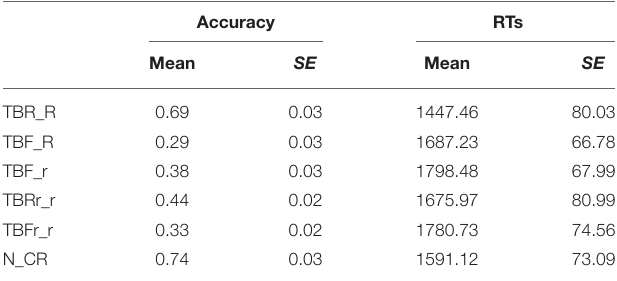
TABLE 2 | Mean accuracy and Reaction times (RTs) in each condition (standard error of the mean).